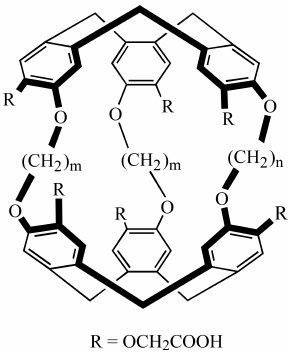
Figure 1. Generic structure of the cryptophanes used in this study. For compound 1: m = 2 and n = 3; for 2: m = 3 and n = 2.